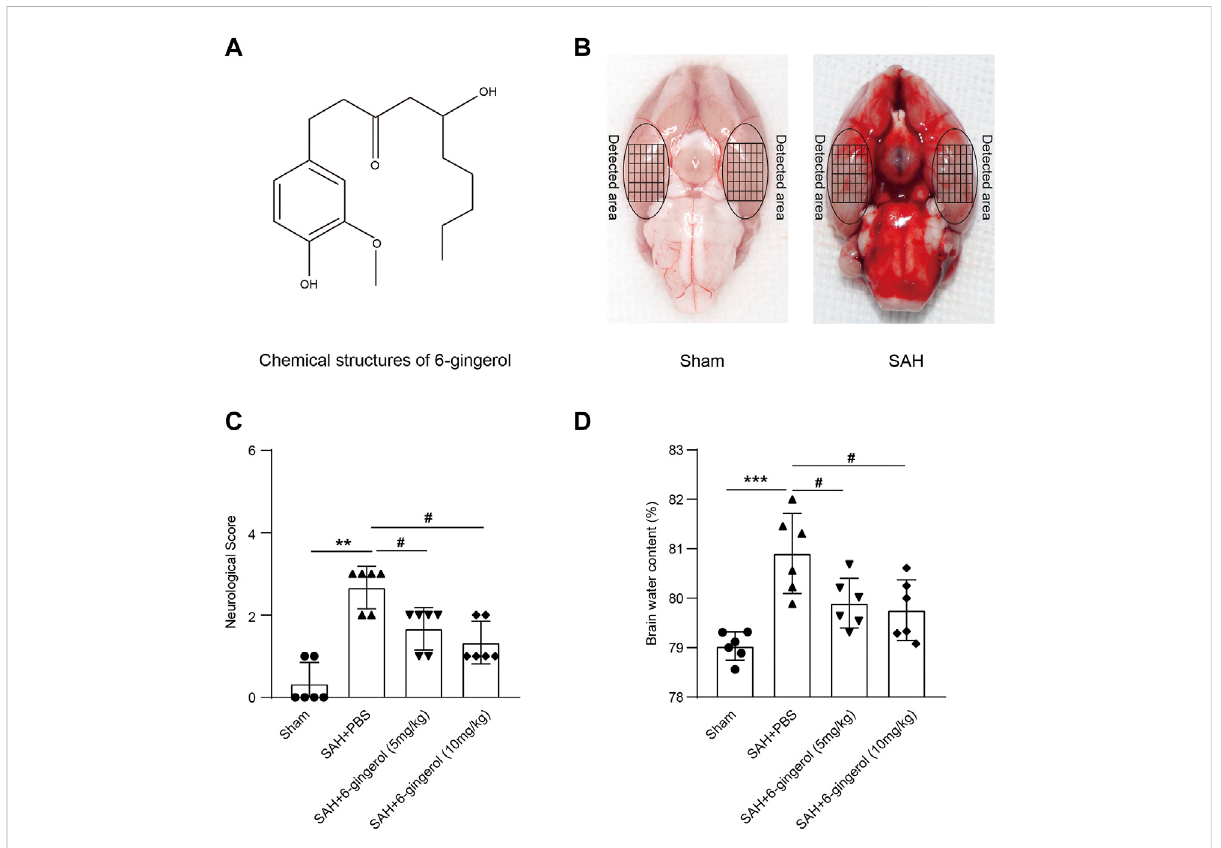
FIGURE 1 6-gingerol improves neurologic function and reduces brain edema in SAH rats. (A) The chemical structure of 6-gingerol. (B) Representative images of the SAH rat brain and the sham rat brain. (C) Quantitative analysis of neurological scores, n = 6, Mann-Whitney U test was used. (D) Quantitative analysis of brain water content, n = 6, One-way ANOVA was used followed by Tukey ’ s post hoc test. ** p < 0.01, *** p < 0.001 vs sham group; # p < 0.05 vs SAH + PBS